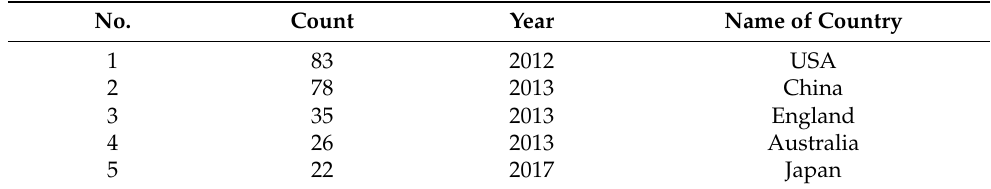
Table 5. Top 5 most productive countries studying epidemic control based on big data research, extracted through CS analysis. No. Count Year Name of